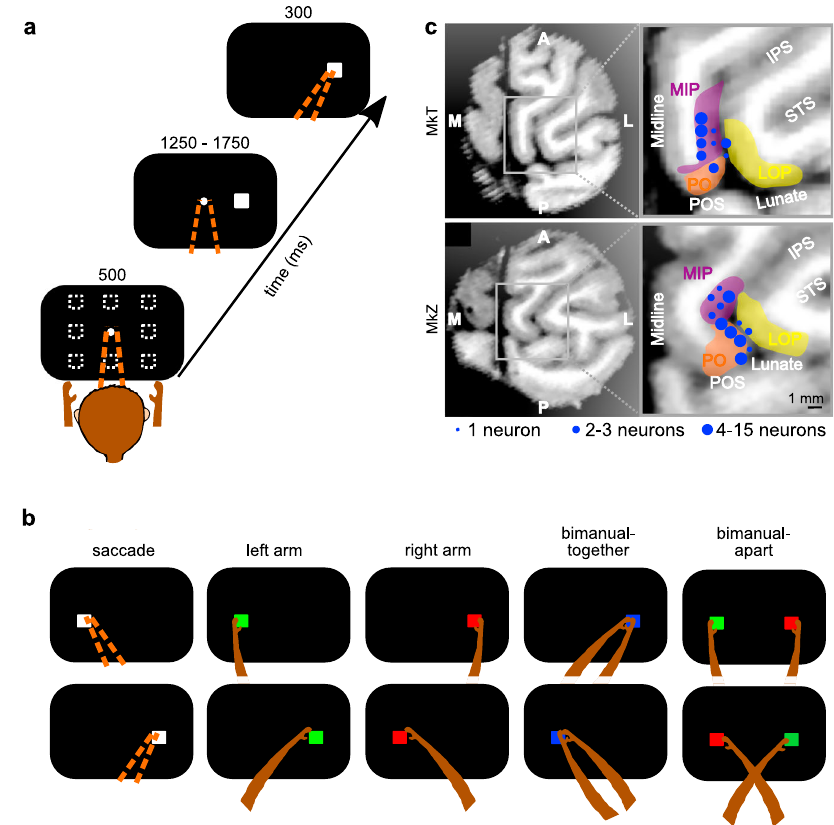
Fig. 1 Delayed movement tasks and recording sites. a On each trial, after an initial fi xation, a peripheral target appeared and instructed the spatial location and effector to be used (eyes or arm[s]) for the subsequent movement(s). The stimulus remained visible during a variable delay period. Throughout saccade and unimanual reach trials, the hand(s) that were not instructed to move were required to remain on the home pad(s). After the go cue ( fi xation offset), animals made the instructed movements to the target location(s). On single-target trials, eye movements to the target were required. Movements were either into or 180 degrees out of the RF. On bimanual-apart reach trials, eye movements were unconstrained once the animals were cued to initiate the movement. One arm moved into the RF and the other arm moved out of the RF on each trial. Movement directions and movement types were randomly interleaved. A saccade-only trial (white stimulus) is depicted. b Unimanual left or right arm reaches were instructed with a single green or red peripheral target, respectively. Reaches with both arms to a single target (bimanual-together) were instructed with a blue stimulus. Reaches with each arm to a different target (bimanual-apart) were instructed with one red and one green stimulus separated by 180 degrees across the central fi xation. Unimanual reaches were either to targets on the same side of the body (upper row) or crossed to the opposite side of the body (lower row). Bimanual-apart reaches were made with the arms either uncrossed (upper row) and or crossed (lower row). Note that only one of the 4 possible target pairs is illustrated. c Recording sites from the right hemisphere of each monkey. Coordinates of recorded cells in MkT (upper row) and MkZ (lower row) are shown projected to a single MRI section perpendicular to the path of the recording electrode, with zoomed-in views on the right. IPS, intraparietal sulcus; Midline, longitudinal fi ssure; POS, parieto-occipital sulcus; STS, superior temporal sulcus. The colored regions are from 89 ; LIP, lateral intraparietal area; LOP, lateral occipital-parietal area; MIP, medial intraparietal area; PO, parietal-occipital area. The medial, lateral, anterior, and posterior directions are labeled as M, L, A, and P, respectively. The size of each circle indicates the number of cells recorded along that track. LFP recordings were obtained at these locations and other sites within 2 mm. Left hemisphere sites (not shown) are